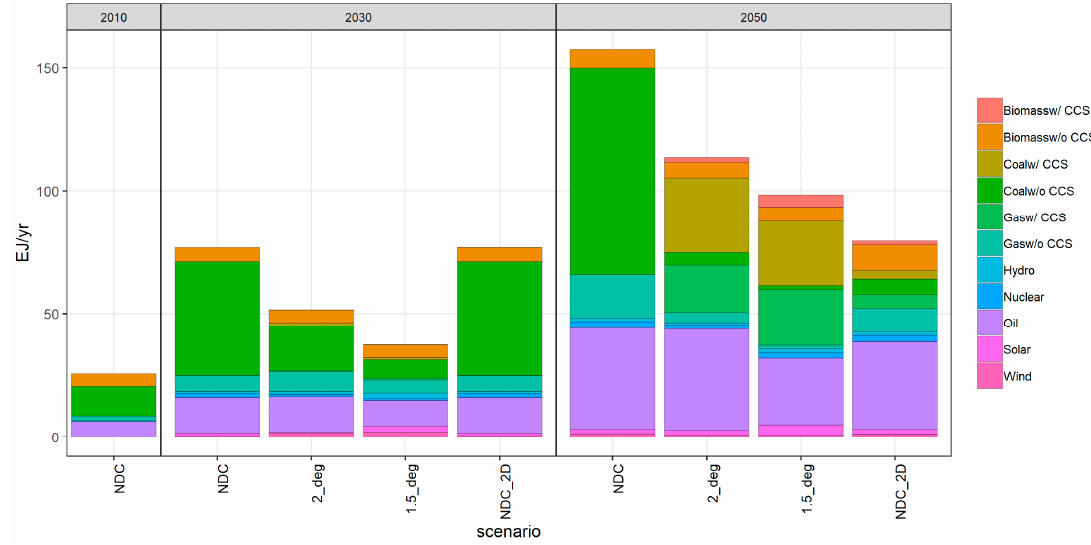
Figure 3. Primary energy mix in different scenarios.